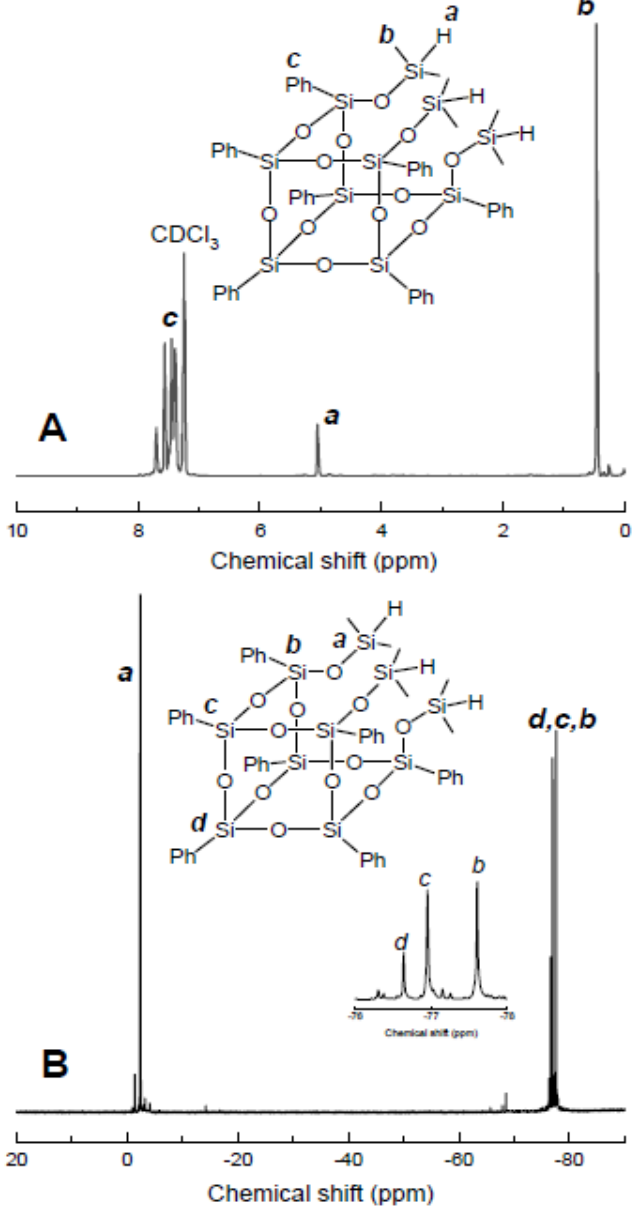
1 H and ( B ) 29 Si NMR